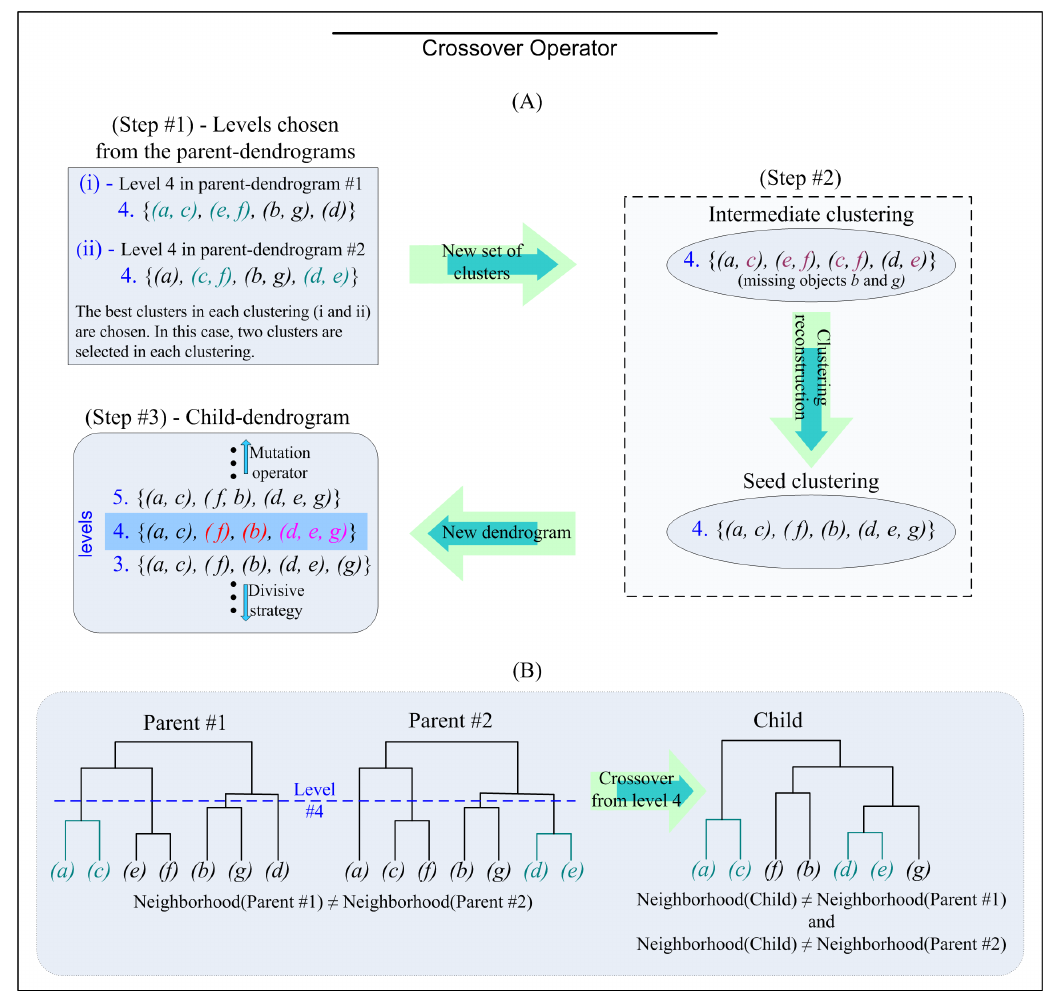
Figure 4: A hypothetical example summarizing the running of the crossover operator defined for the EMHC method. (A) shows the crossover process from the internal structure of the dendro- grams whereas (B) shows the same, but from the graph of the